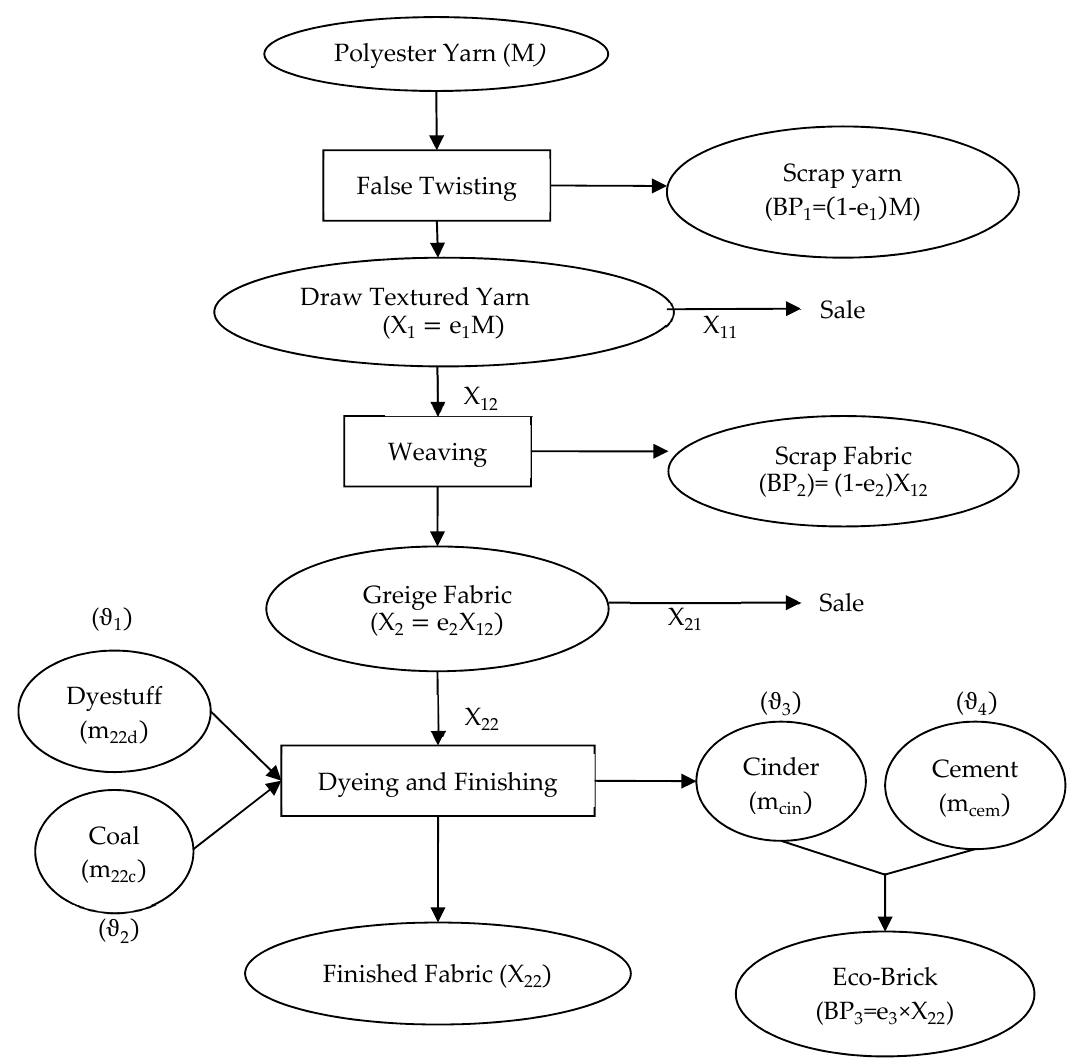
Figure 4. Textile manufacturing process with the symbols of quantity variables.